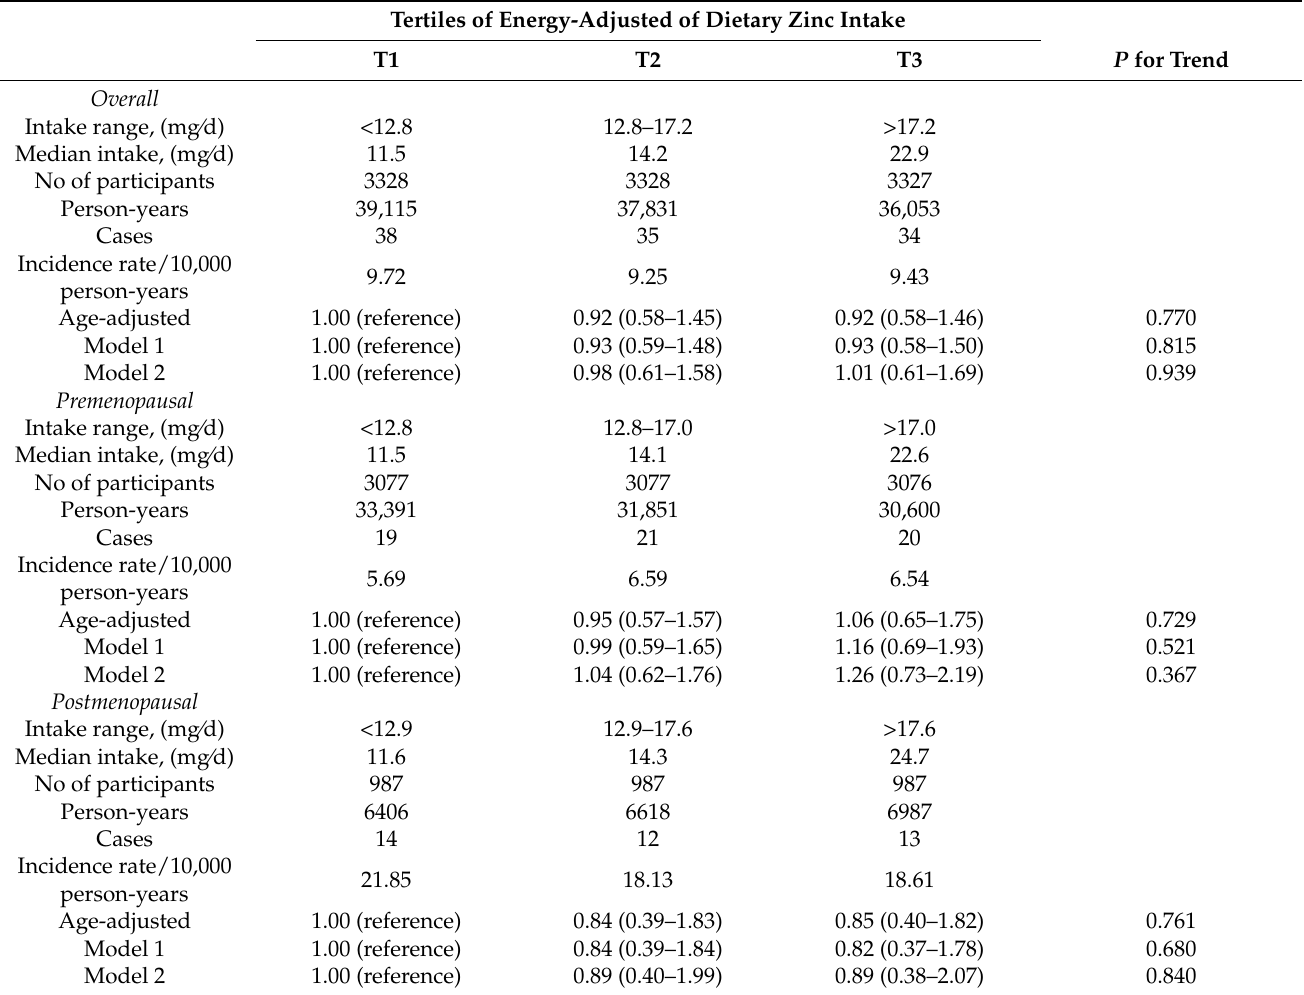
Table 6. Dietary zinc intake. Hazard Ratio (HR) and 95% Confidence Interval (CI) of breast cancer by tertiles of energy- adjusted dietary zinc at baseline among female participants of the SUN